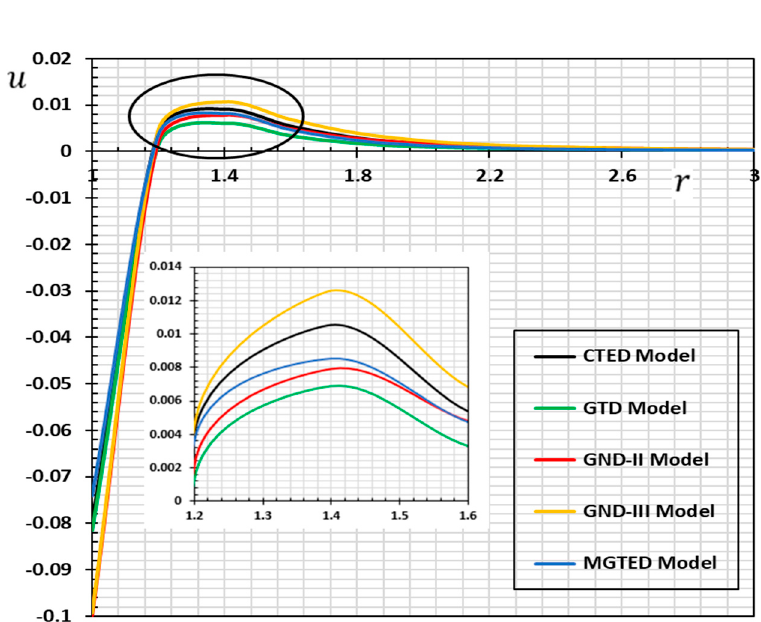
Figure 2. The displacement 𝑢 for different thermo-diffusion